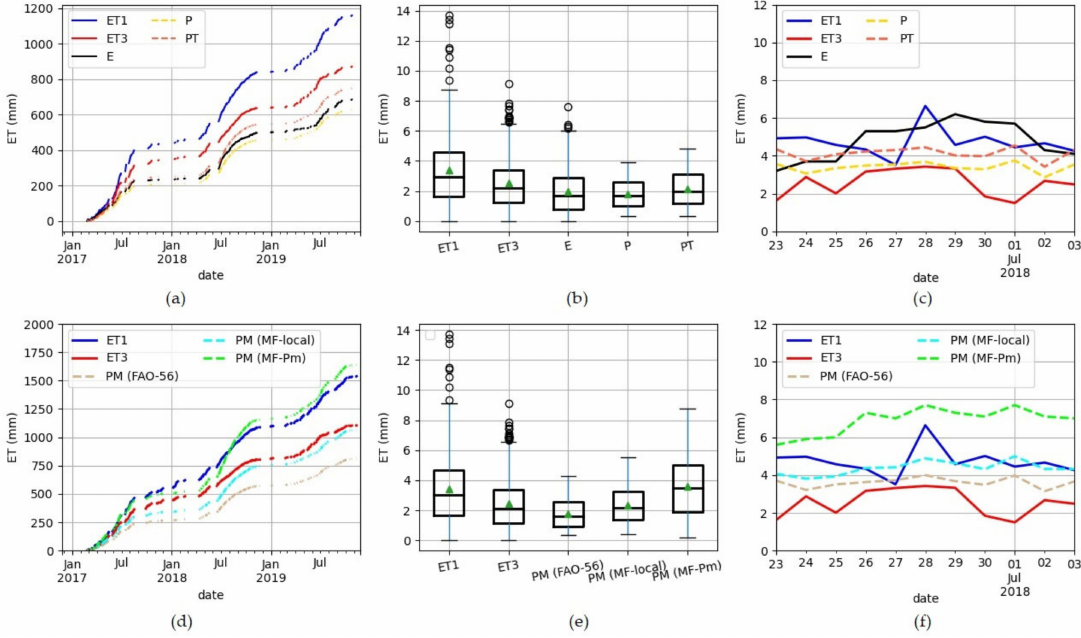
Figure 10. Evapotranspirations (ET) from the lysimeter 1(with internal water storage), the lysimeter 3 (without internal water storage), the evaporimeter, and the potential ET models: ( a – c ) compare the Penman (P) and Priestley–Taylor (PT) potential ETs to ET1 and ET3 (data = 346) and respectively present the cumulative ET values, the boxplots, and the ET dynamics for a dry period (24 June to 3 July 2018); ( d – f ) refer to the ET1, ET3, Potential ET of FAO-56, and Meteo-France models (data = 453) and show, respectively, cumulative ET values, boxplots, and ET dynamics for a dry period (24 June to 3 July 2018). PM and Pm refer respectively to Penman–Monteith and